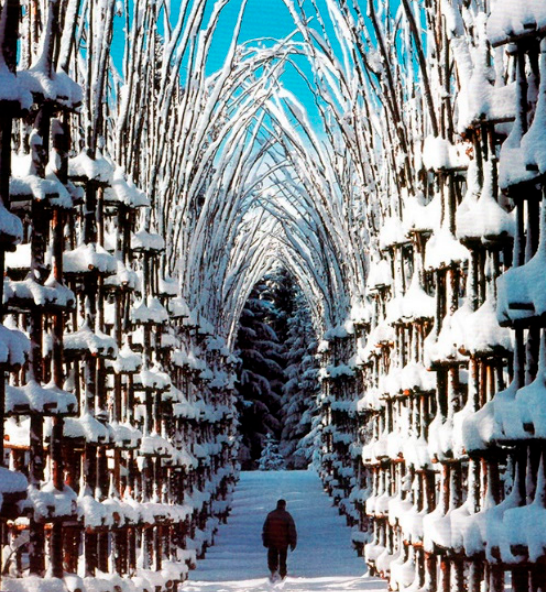
Figure 3. Giuliano Mauri, Cattedrale Vegetale , installed at Arte Sella in 2001. Source: http://www.giulianomauri.com/test/cattedrale-vegetale-orobie/, accessed on 12 August 2022. Photo: Aldo Fedele. Courtesy Archivio Giuliano Mauri.